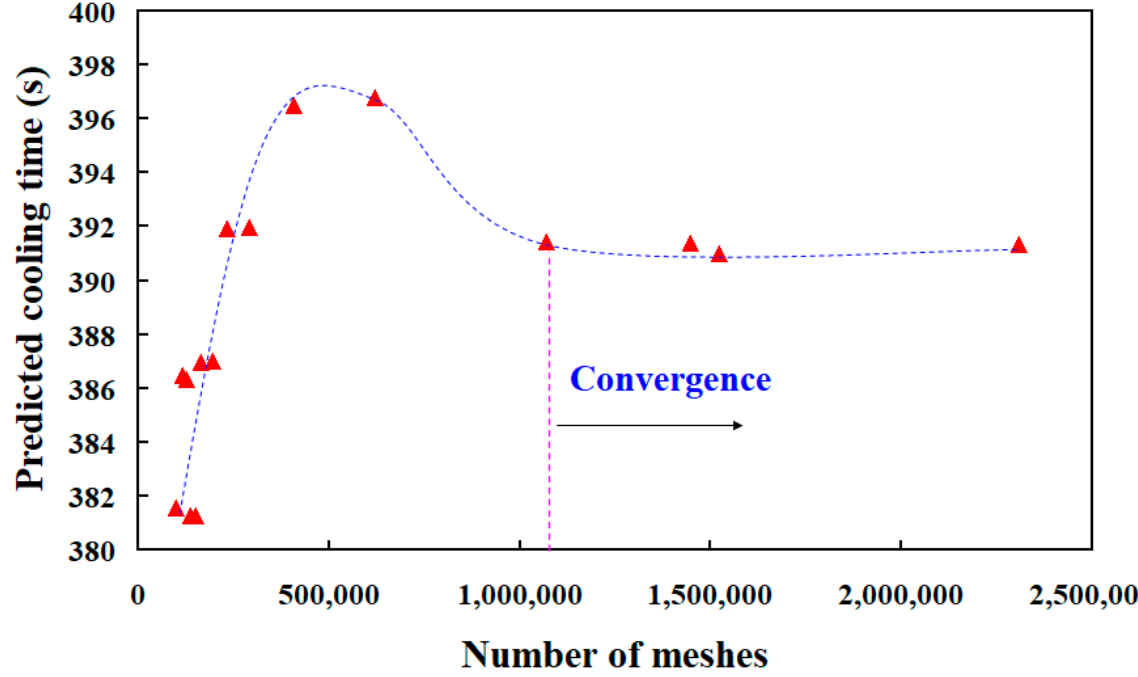
Figure 11. Number of meshes as a function of the cooling time of the injection molded product.